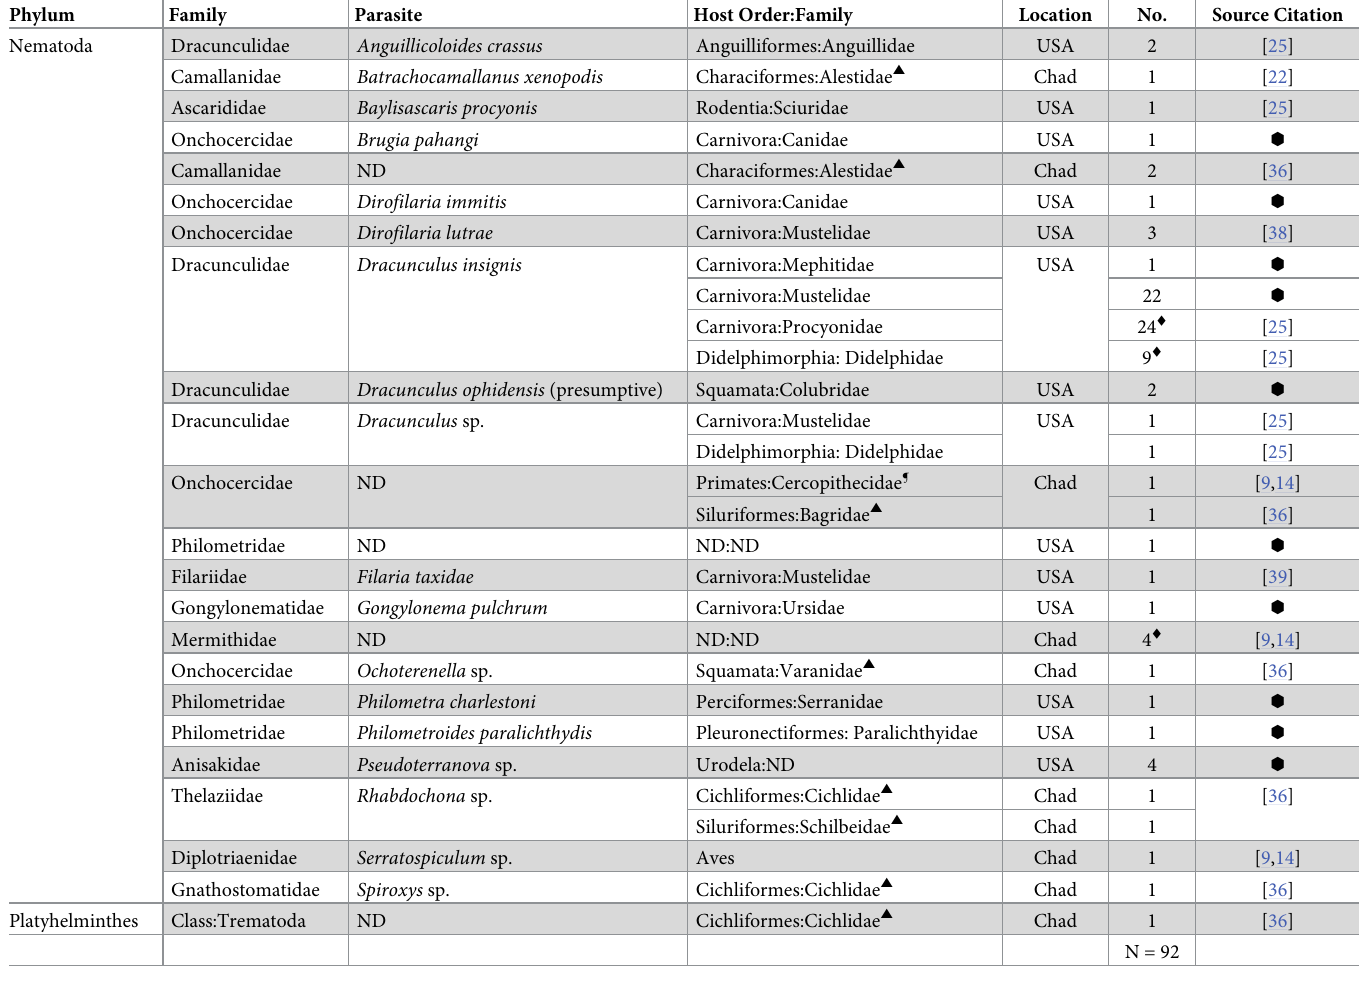
Table 4. Summary of non-target parasite samples used to estimate diagnostic sensitivity and specificity showing taxonomic grouping, location of origin, and num- ber of samples. Phylum